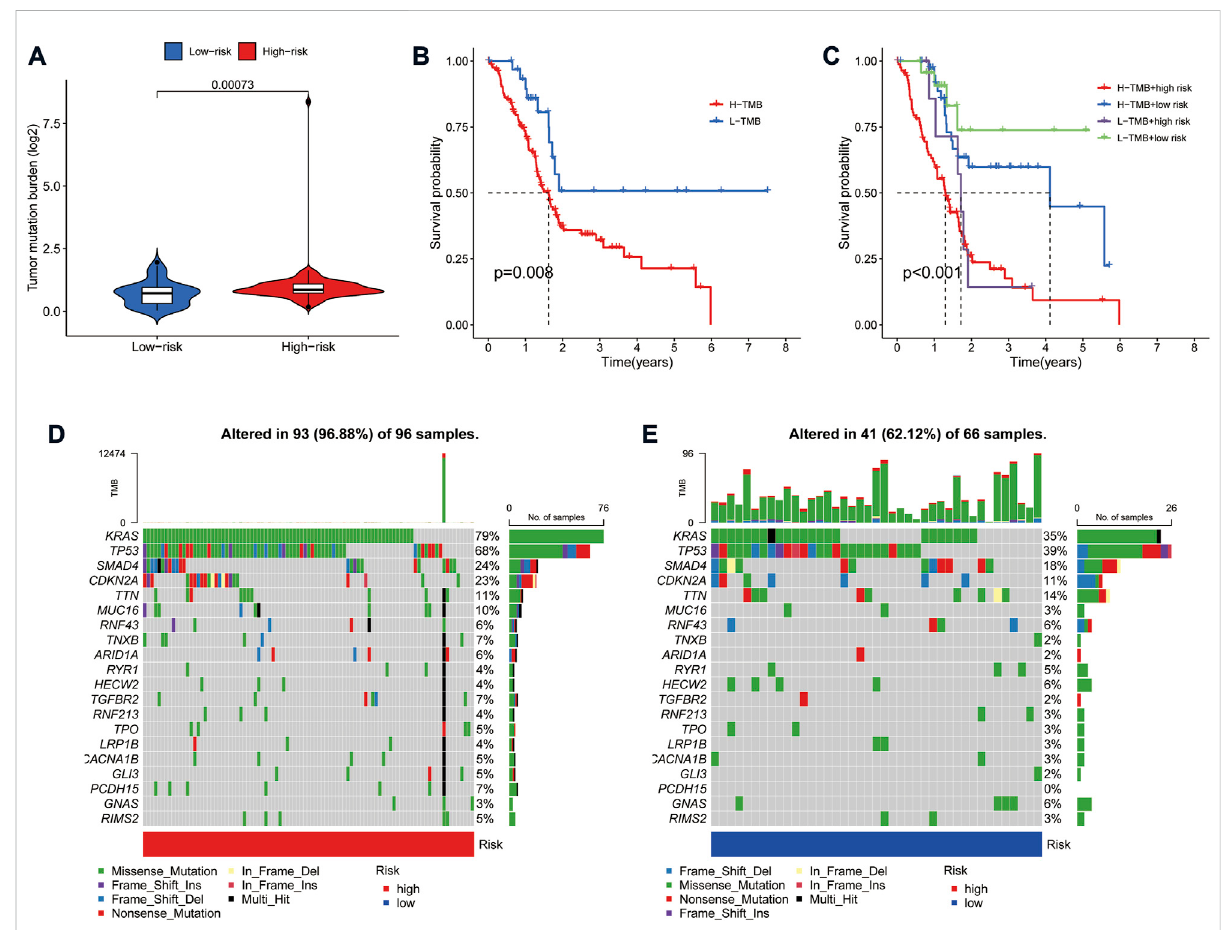
FIGURE 7 Correlation of risk model with tumor mutation burden in PAAD. (A) Violin plot of TMB status in the high- and low-risk groups (B) Kaplan Meier curve of high-TMB and low-TMB. (C) Kaplan-Meier curve of TMB + Risk. (D) Mutant gene waterfall plot in the high-risk group. (E) Mutant gene waterfall plot in the low-risk